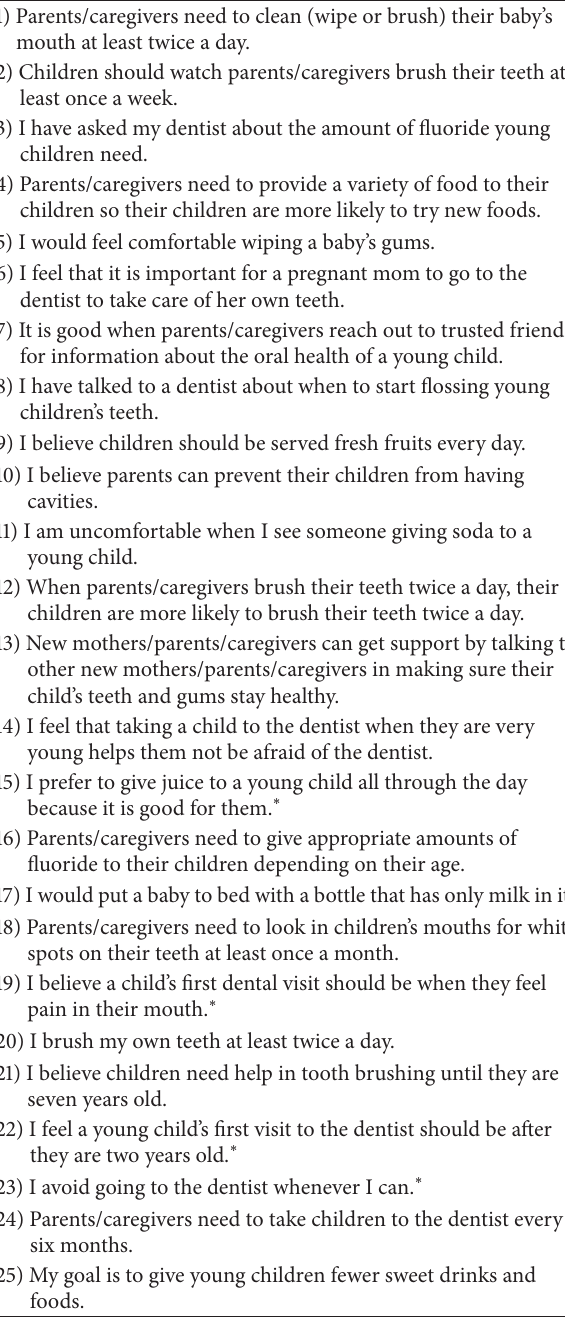
Table 4: Pre- and posttest attitudes/behavior items—5 point Likert Scale, 25